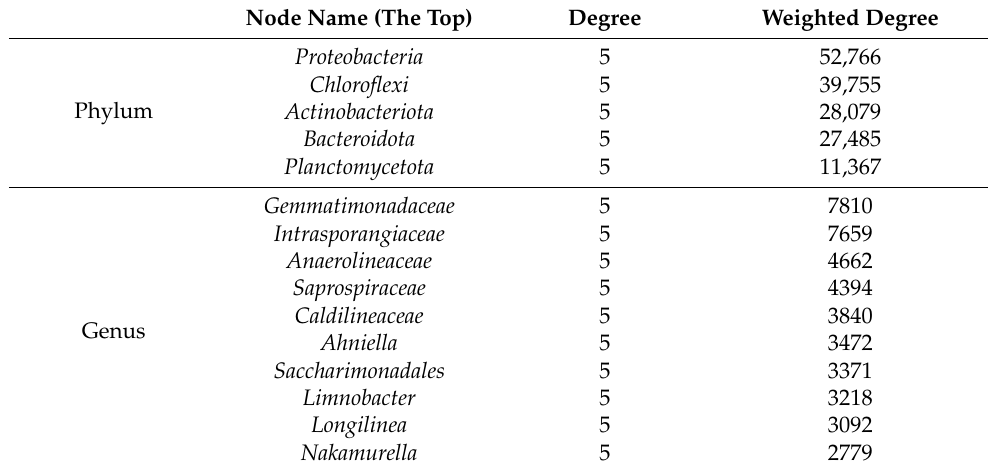
Table 3. The bacterial nodes at the phylum and genus levels of the microbial communities associated with the wastewater treatment plants.